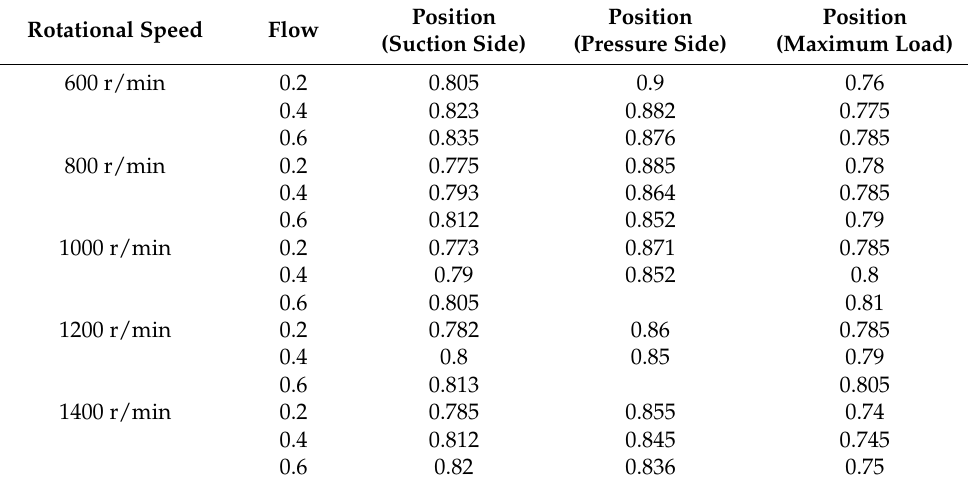
Figure 9. The mean absolute flow angle distribution curve under the five rotational speeds. In addition, it was found that the blade load distribution trends for some flow rates and some rotational speeds were different from the overall distribution trend. At the ro- tational speeds of 600 r/min and 1400 r/min, the blade load distribution curves for the flow rate of 0.8 Q BEP were closer to the flow rate of 0.6 Q BEP compared with the situation at other rotational speeds. For the rotational speeds of 1000 r/min and 1200 r/min, at flow rate of 0.6 Q BEP , the development trend of the first half blade load distribution curves were consistent with that at the flow rate of 0.2 Q BEP and 0.4 Q BEP . However, the latter half of the curves began to move away from that at the flow rates of 0.2 Q BEP and 0.4 Q BEP , and the positions of the maximum values were significantly closer to the impeller outlet. The specific values are shown in Table 3. Table 3. The position of the maximum blade load and the vortex centers.